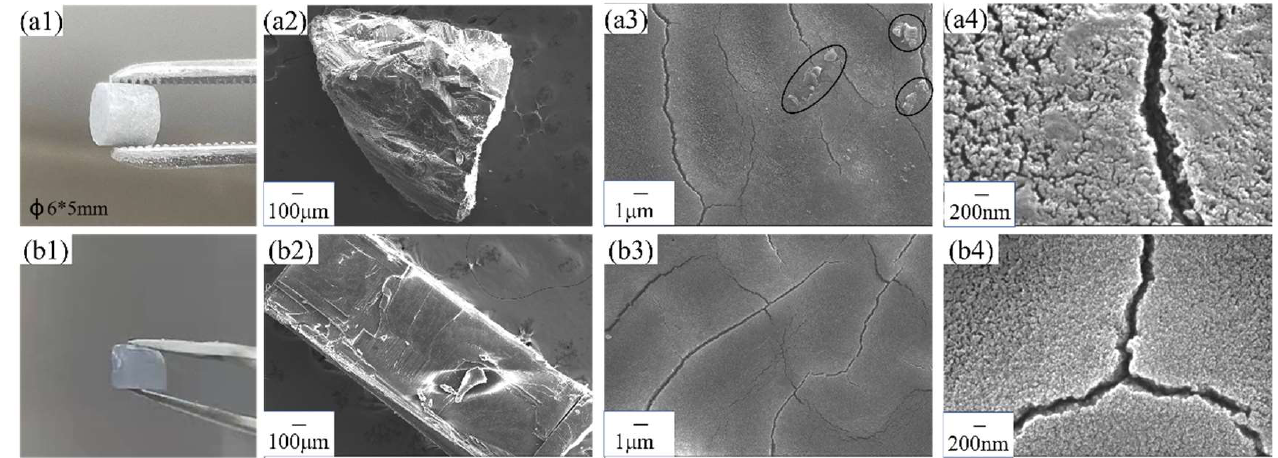
Figure 13. ( a1 ) Polycrystalline LiH partical, ( a2 ), ( a3 ), ( a4 ) are SEM of polycrystalline LiH with scaleplate of 100 μ m, 1 μ m, 1nm, respectively; ( b1 ) Single crystal LiH partical, ( b2 ), ( b3 ), ( b4 ) are SEM of Single crystal LiH with scaleplate of 100 μ m, 1 μ m, 1nm, respectively.